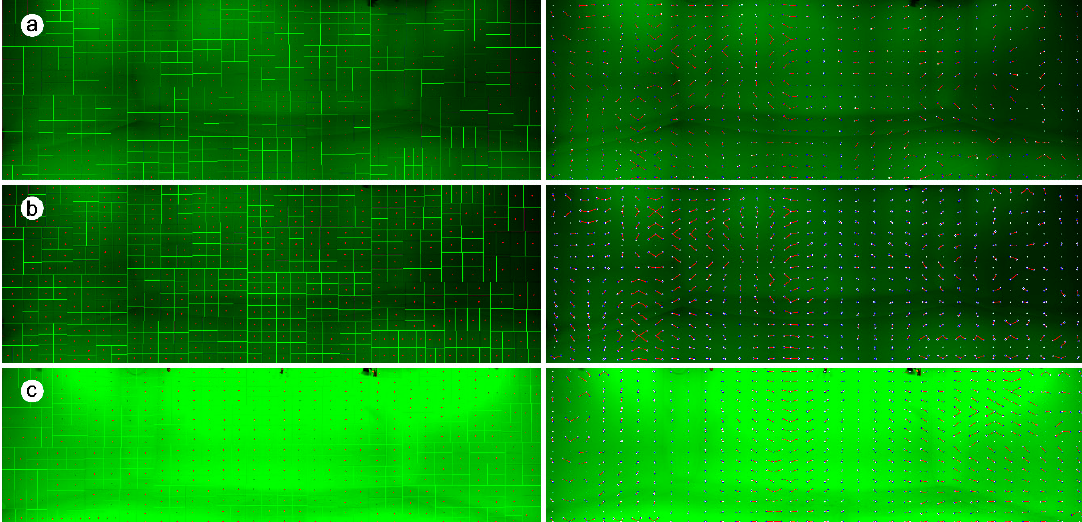
Figure 8. Images of the three steps process of correcting the cyclorama illumination: original configuration ( a ), first correction ( b ) and second correction ( c ). The images represent the 512 regions subdivision ( left ) and the centroid correspondence ( right ).